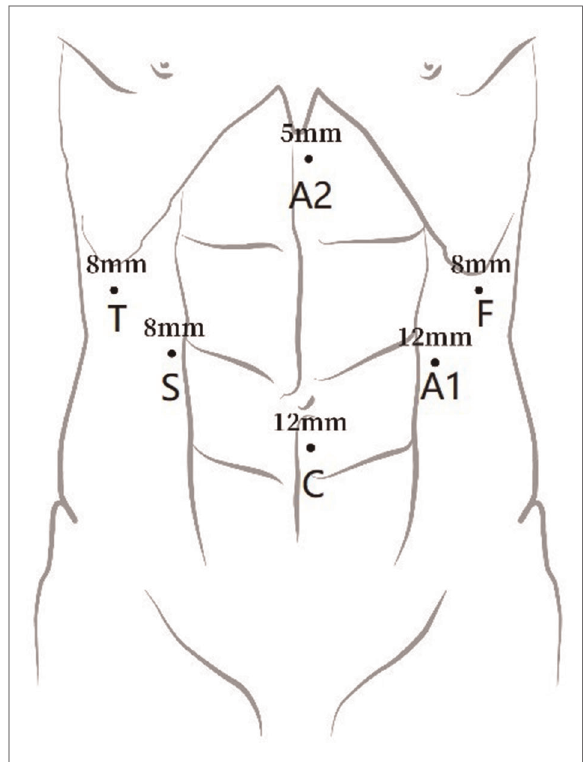
FIGURE 2 Port placement for abdominal robot-assisted minimally invasive esophagectomy. C, camera port; A1, assistant port 1; A2, assistant port2;F, fi rstroboticarm;S,secondroboticarm;T:thirdroboticarm.